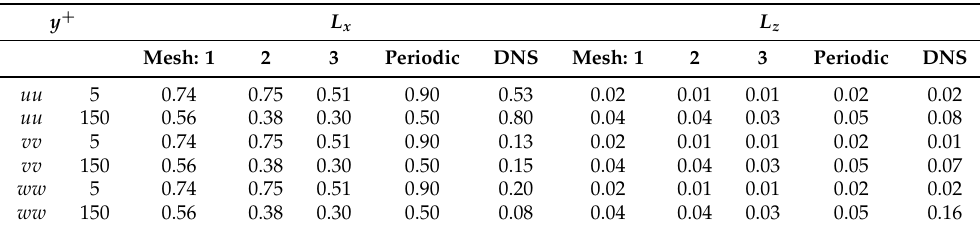
Table 2. Integral length scales.